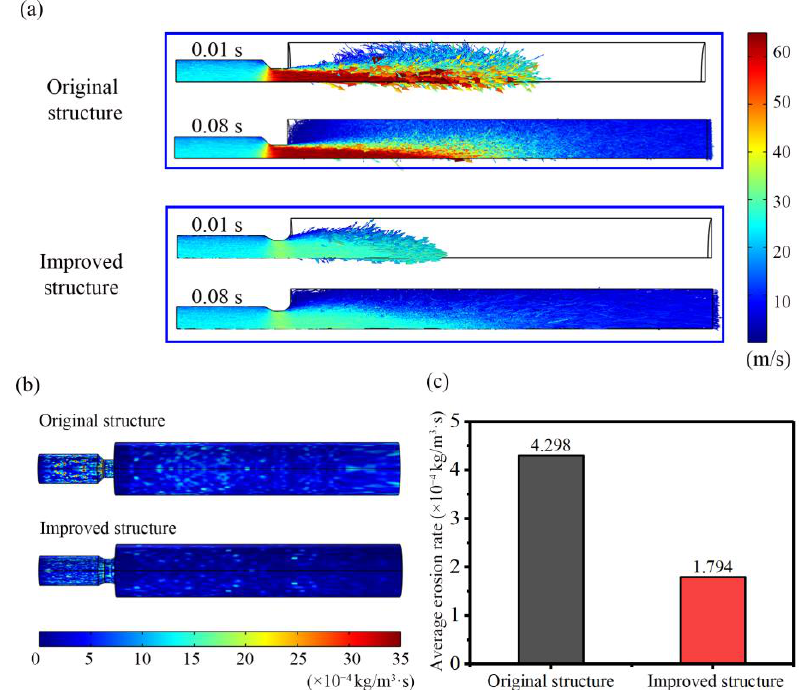
Figure 16. ( a ) Particle trajectories of the original and improved differential motion assembly; ( b ) the erosion contours of the original and improved differential motion assembly; ( c ) the average erosion rate of the original and improved differential motion assembly; the fluid viscosity was set as 100 mPa · s and the inlet flow rate was 0.04 m 3 /s.